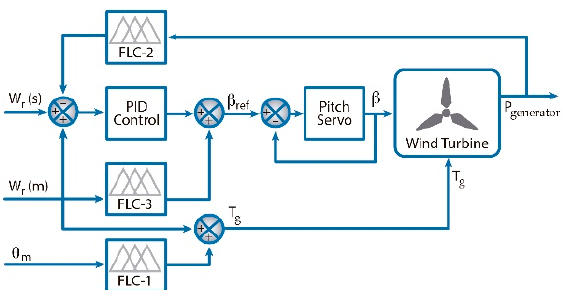
Figure 7. Control strategy with different control loops or different types of controllers, each control signal is added to obtain an equivalent signal [48].